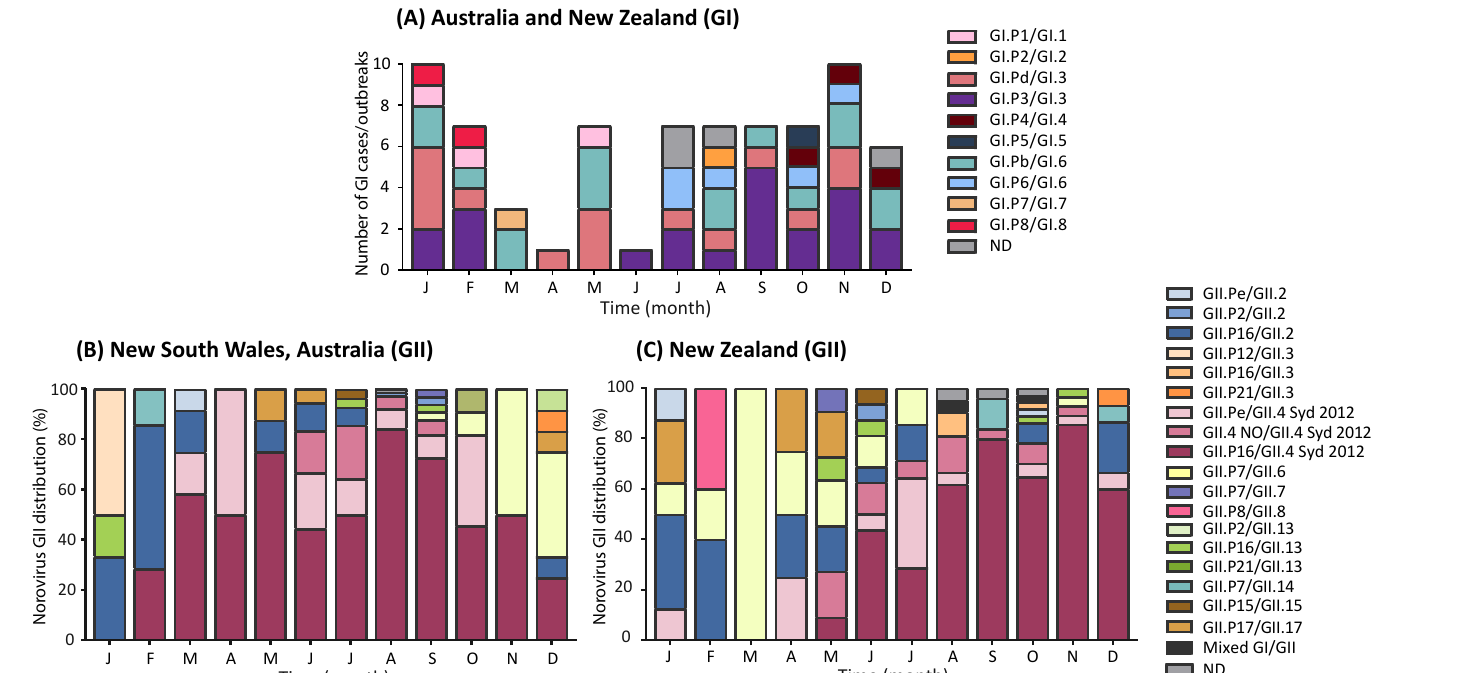
Figure 3. Monthly distribution of norovirus genotypes identified in the Oceania Region in 2017. ( A ) The number of GI norovirus genotypes identified in the Oceania region (Australia and New Zealand) during the study period. A total of 73 samples were collected and identified as GI norovirus, 52 cases were linked to outbreaks and the remaining were sporadic cases ( n = 21). Both polymerase and capsid regions were sequenced to determine its genotype, with each genotype denoted by different colors as indicated in the legend. The ND represents samples that had incomplete genotyping results where only the capsid or the polymerase region was determined. ( B ) The monthly genotype distribution of GII noroviruses identified in New South Wales, Australia, throughout the study was examined. A total of 220 GII cases were identified in this study, where 44 were linked to outbreaks and the remaining were considered sporadic cases ( n = 176). ( C ) All samples collected from New Zealand were of outbreak samples and a total of 184 GII outbreaks were investigated in 2017. The monthly genotype distribution of GII noroviruses are